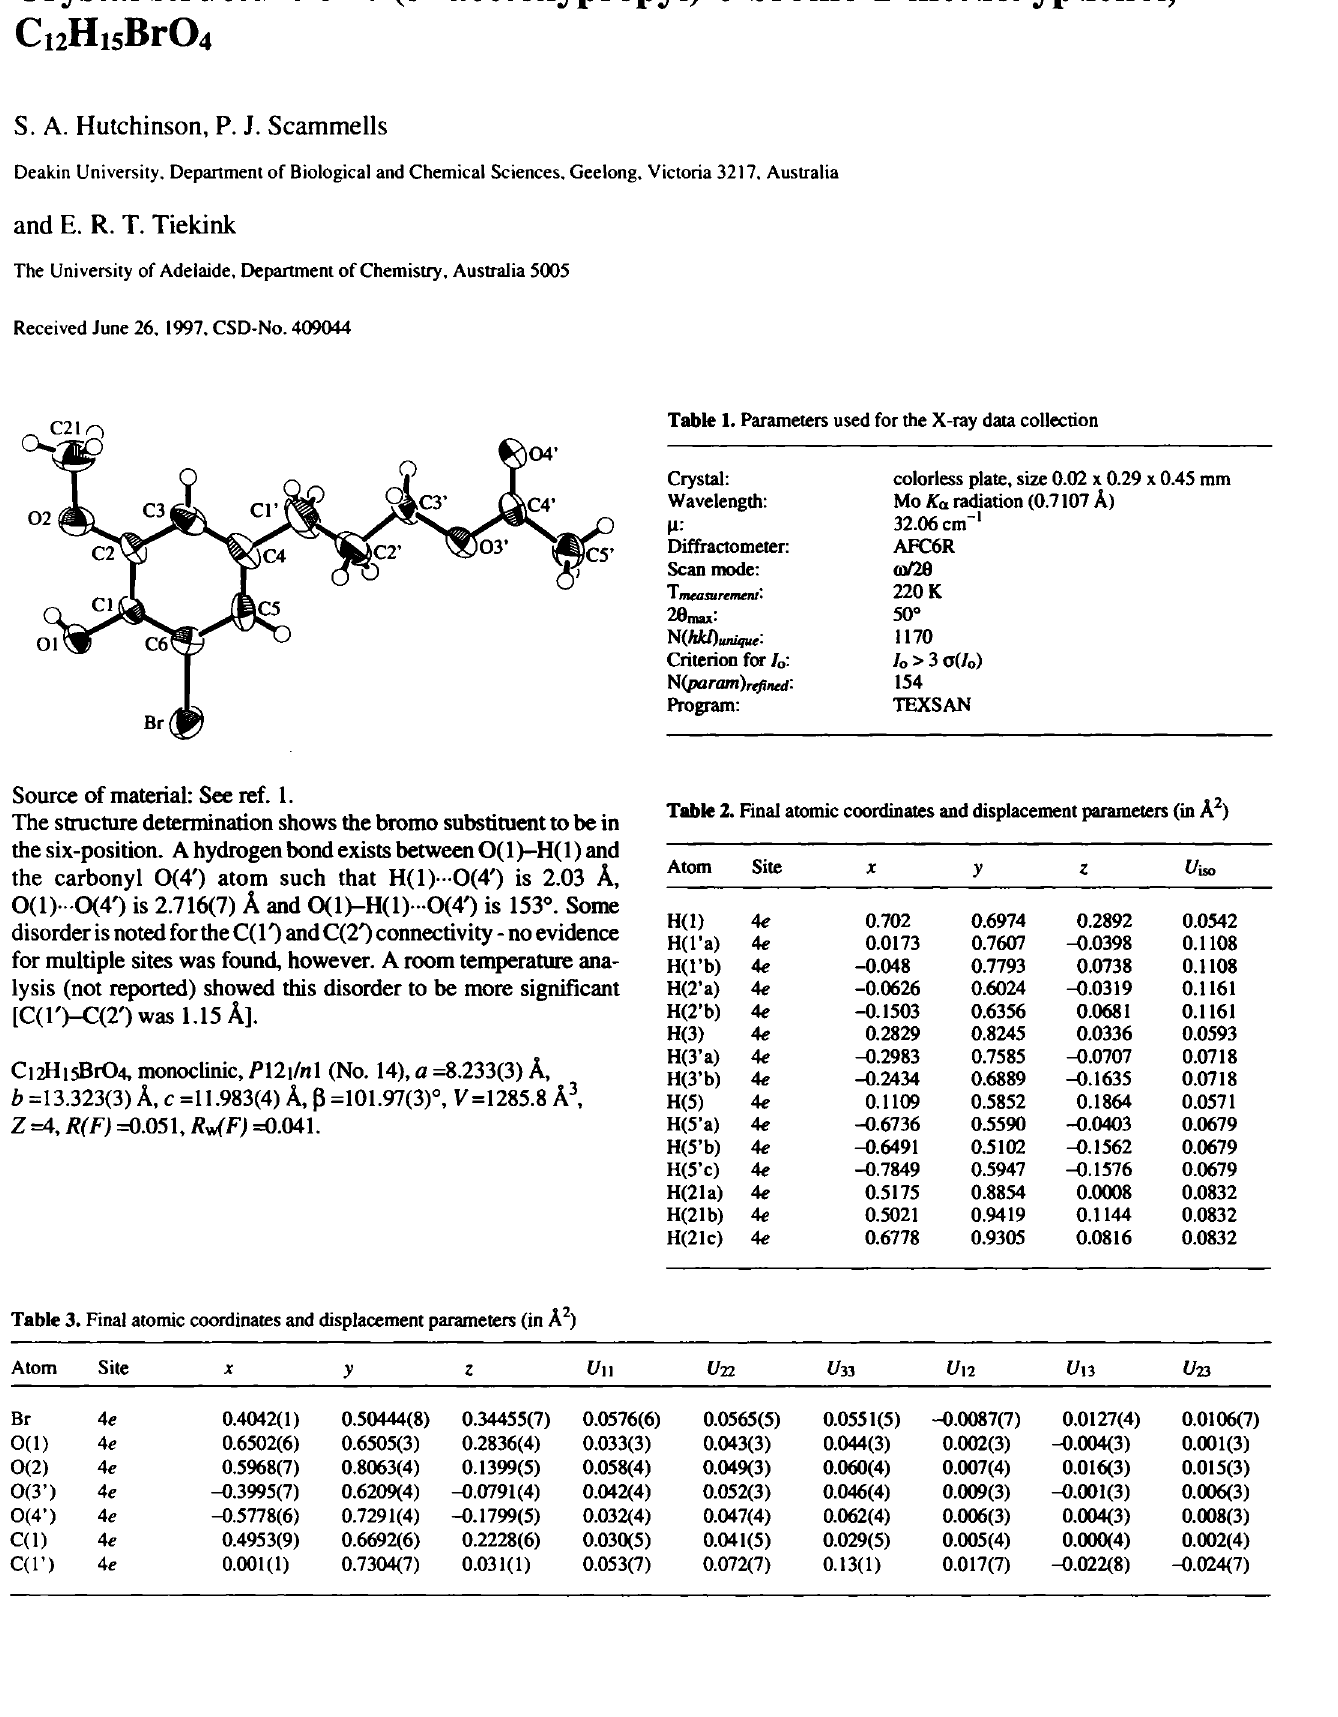
Table 1. Parameters used for the X-ray data collection Crystal: